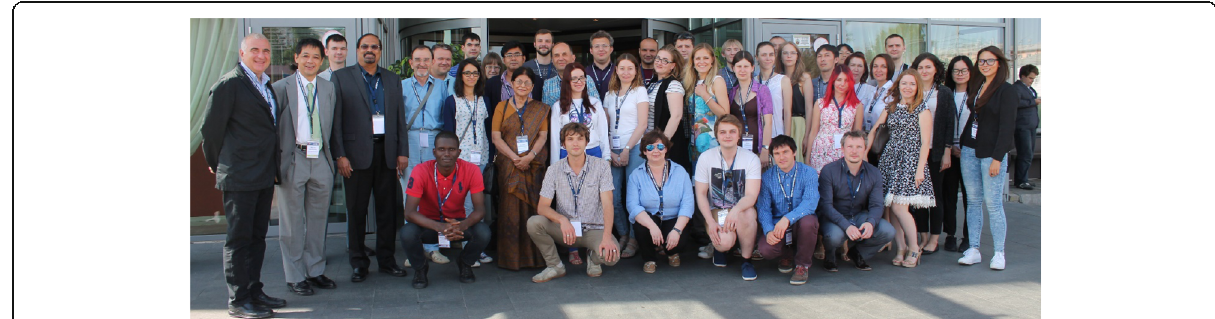
Fig. 21 Photo of a VarSITI School on July 2017 at Irkutsk, Russia, with 35 students from 5 countries